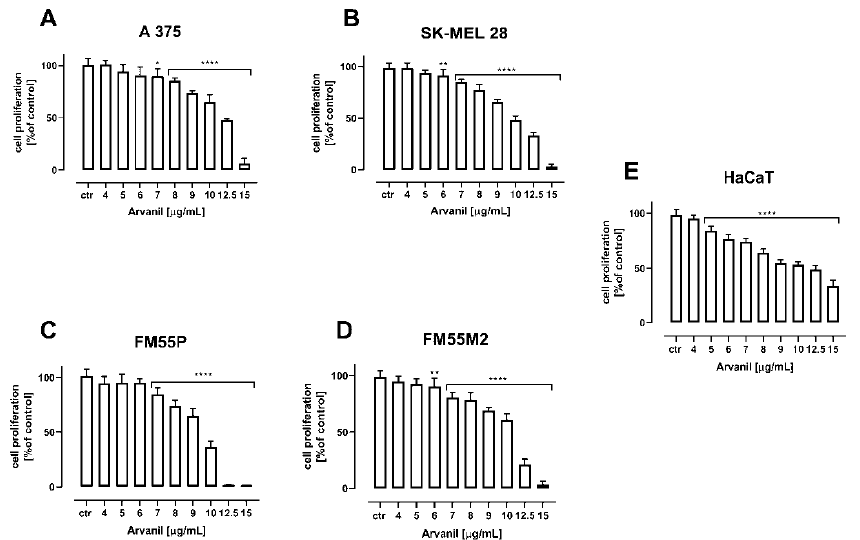
Figure 6. The effect of arvanil on the proliferation of malignant melanoma cell lines [A375 ( A ), SK–MEL 28 ( B ), FM55P ( C ), FM55M2 ( D )], and normal human keratinocytes [HaCaT] ( E ) measured by means of BrdU assay after 72 h. Results are presented as mean ± SEM (* p < 0.05, ** p < 0.01, **** p <